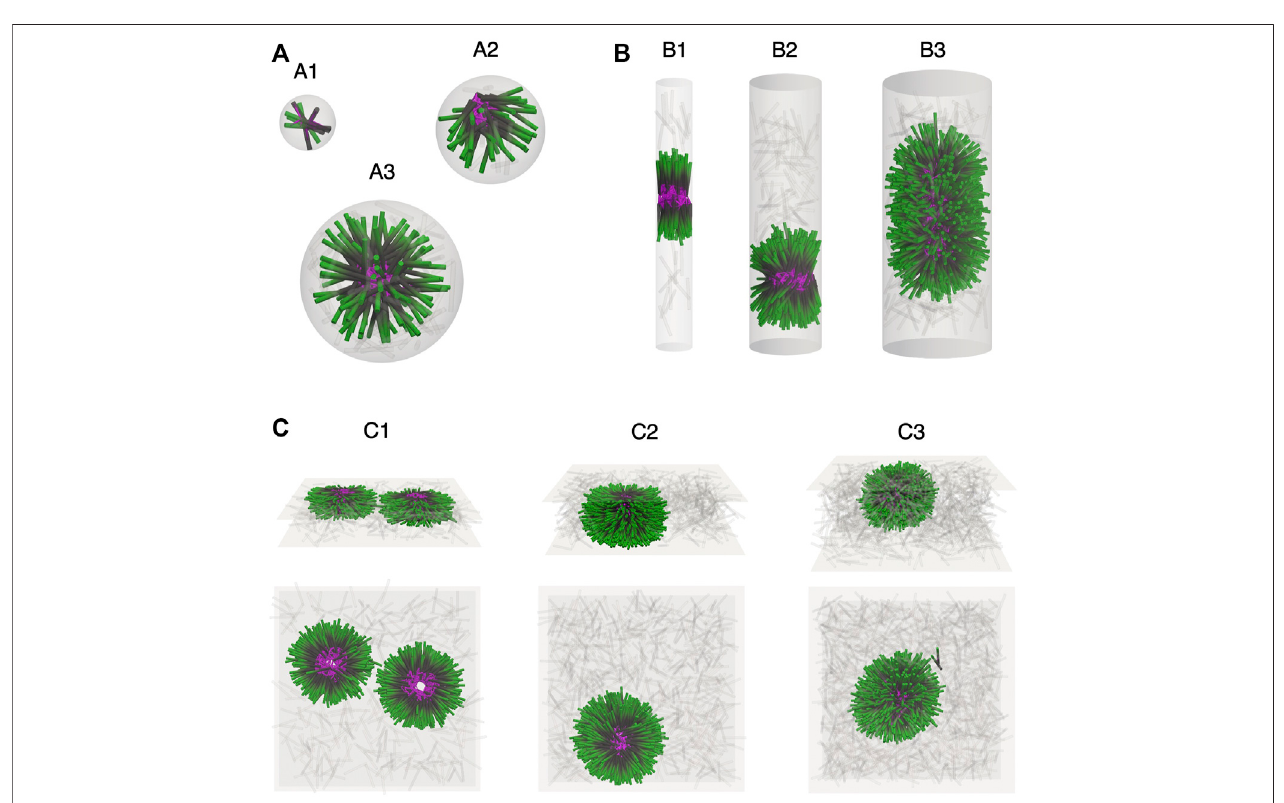
FIGURE 2 | Con fi nement lengthscale alters fi lament self-organization and steady-state morphology. Simulation snapshots showing fi laments (minus end green, plus end black) of length L and end-pausing crosslinking motors (pink). Filaments in the vapor have been grayed out. (A) Spherical con fi nement in a sphere of varying diameterD. (A1) D = L .Smallsphericalboundaryinhibitsextensileforcegenerationofthemotorproteinsandnotipaccumulationisobserved. (A2) D =2 L .Thecon fi ning sphereisjustlargeenoughtoallowforextensilestressgeneration,andcrosslinkingmotorproteinsaccumulateat fi lamentplusendstoformahalfasterwhosecore is visible at the edge of the sphere. (A3) D = 3 L . Filaments self-assemble into a symmetric aster centered in the con fi ning sphere. (B) Cylindrical con fi nement of 1,600 fi laments and 4,800 crosslinking motors in cylinders of varying diameter D. Snapshots show a 2 µm long section of the simulation cylinder. (B1) D = L . Filaments form polarity-sorted bilayers, each one held together by a core of crosslinking motors. (B2) D = 2 L . An asymmetric aster showing a degree of orientational alignment of microtubules along the axis of the cylinder. (B3) D = 3 L . A bottle-brush-like aster with an elongated core of crosslinking motors. Filaments point radially in towards the surfaceofthecrosslinker core. (C) Planarcon fi nement of1,600 fi laments and 4,800crosslinking motorproteins betweentwosurfaces withseparationH. (C1,C2) H = L and H = 2 L . Flattened asters with a hollow fi lament core. (C3) H = 3 L . The surface separation is large enough to accommodate a full, albeit slightly elongated, aster.